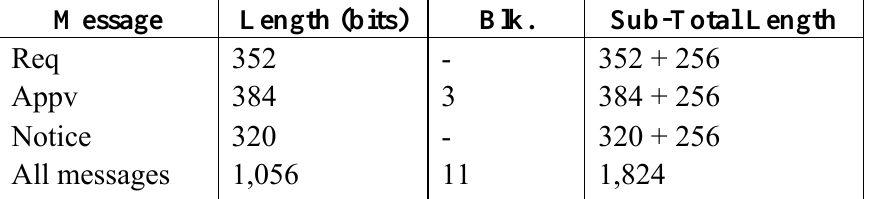
Table 5. Message length of our